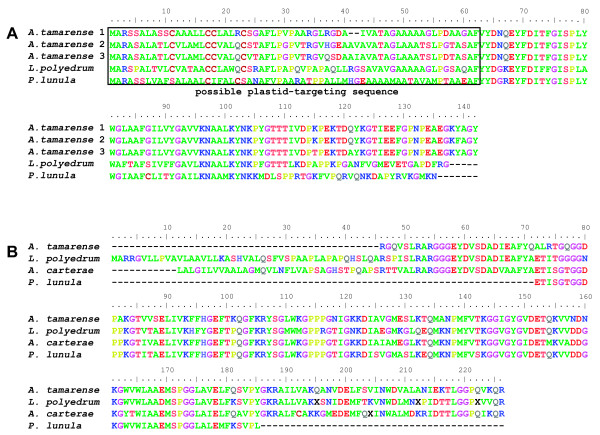
Putative dinoflagellate-specific proteins. Amino acid sequence alignments of putative dinoflagellate-specific proteins. A) putative plastid protein that was highly represented in the A. tamarense cDNA library (cluster size = 22). A. tamarense sequences 1, 2, and 3 correspond to clones GC1-aba-e-13, GC1-abh-e14, and GC1-abd-o-22, respectively, and are aligned with highly similar ESTs from the dinoflagellates L. polyedrum (CD809498) and P. lunula (BU582532). The boxed region indicated a possible plastid targeting sequence. B) Putative dinoflagellate specific protein with significant blast hits only to other dinoflagellate ESTs. The Alexandrium sequence corresponds to clone UI-D-GC1-abh-f-23-0-UI.